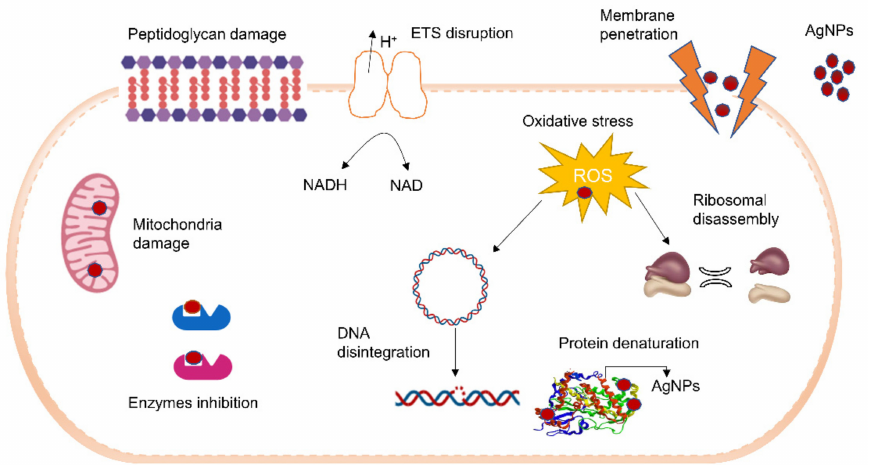
Figure 3. Antibacterial mechanism of Chinese herb-synthesized AgNPs. Antibacterial mechanism possibly shows that AgNPs bind to the bacterial cells and lead to the following results: (1) cell wall and cell membrane degradation, (2) penetrate intracellularly and denature proteins and damage DNA, (3): enzyme inactivation by oxidative stress generated by